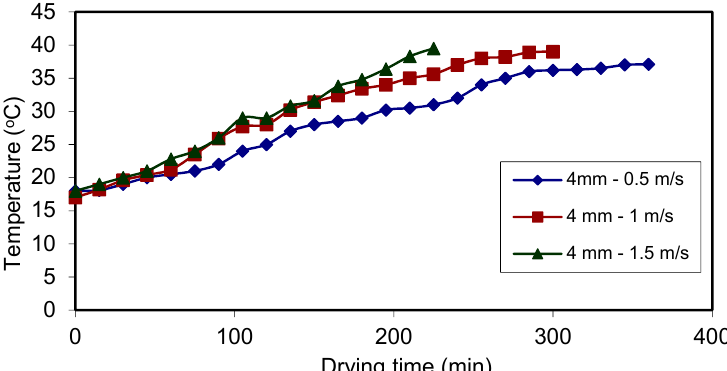
Figure 7. Surface temperature as a function of drying time for drying air velocity of 0.5, 1 and 1.5 m/s and slice thicknesses of 4 mm for kiwi fruits.